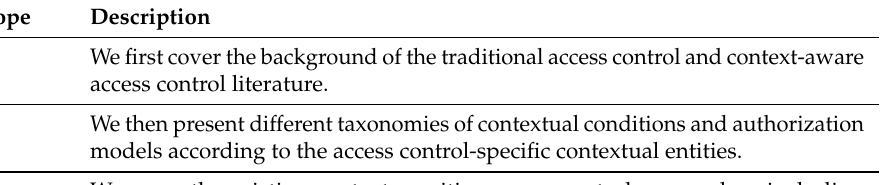
Table 1. The scope and contributions of the